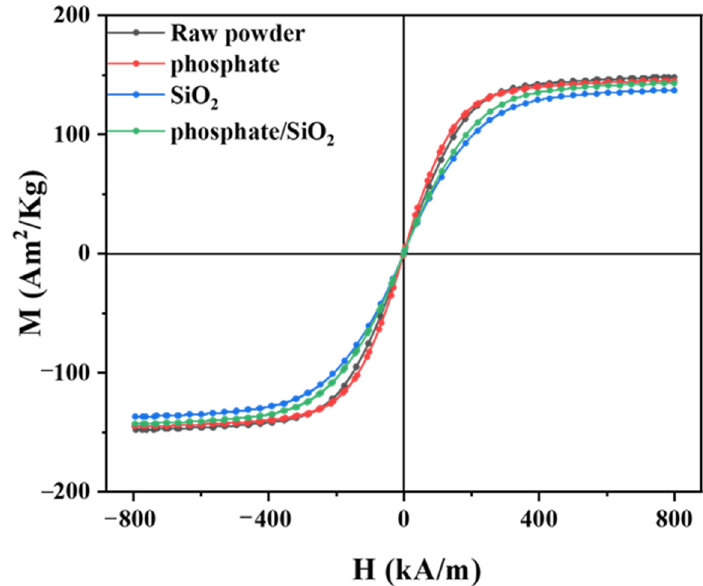
Figure 7. Magnetic hysteresis curves of FeSiBCr powders for different treatment